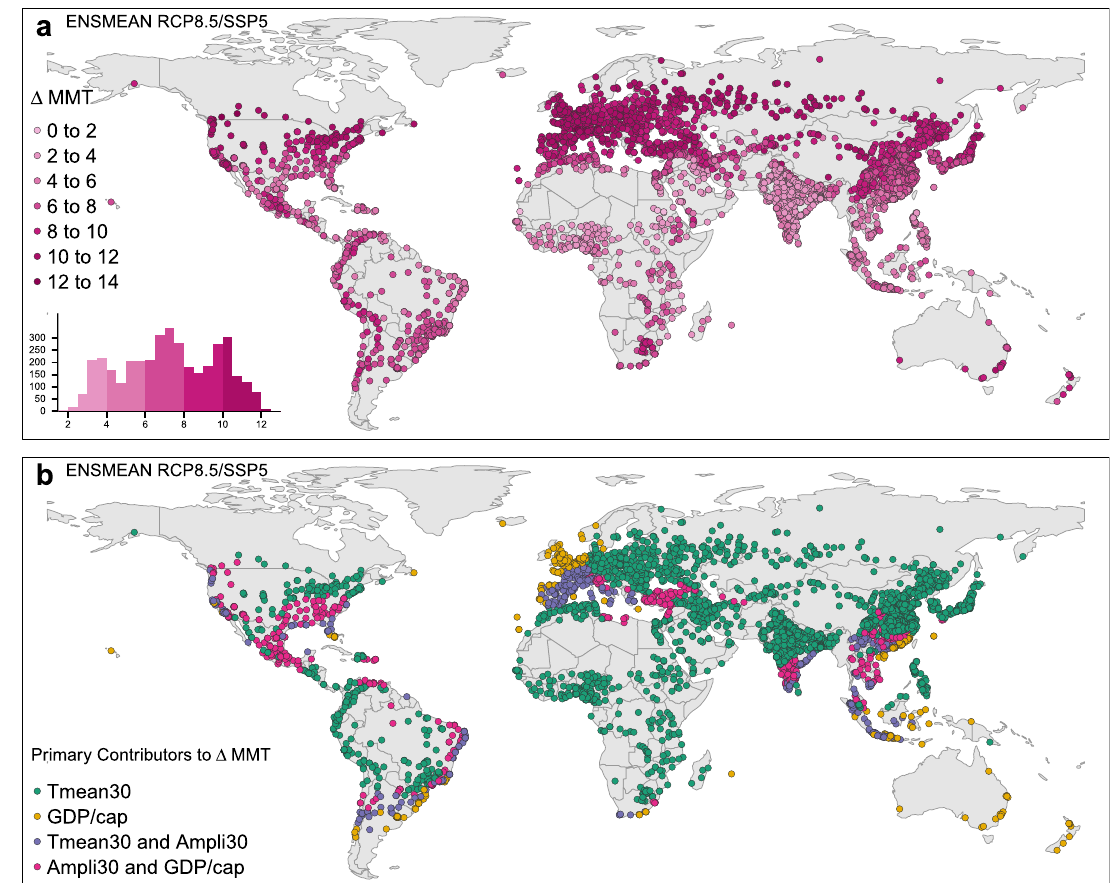
Figure 4. Changes in adaptation until 2100 and their primary contributors to (cid:31) MMT in a RCP8.5/SSP5 future. (cid:31) MMT 2000–2100 for RCP8.5/SSP5 for major world cities ( a ). Contributions of the single variables’ 2000–2100 changes to (cid:31) MMT 2000–2100 for RCP8.5/SSP5 ( b ). (Map created in R (version 3.6.2) 28 using the tmap package (version 2.3-2) 29